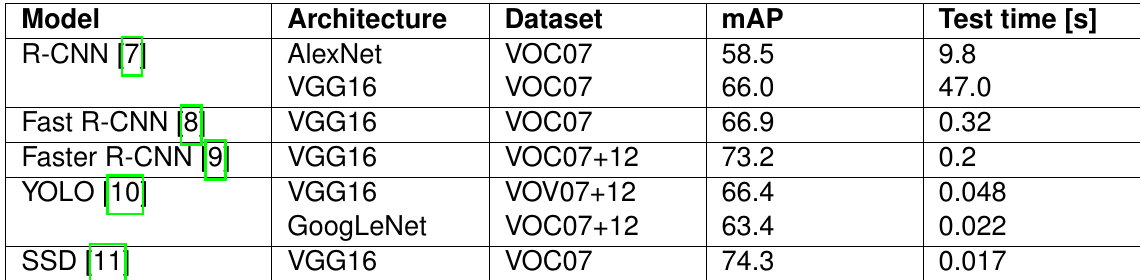
Table 1. Comparison of different object detector models.